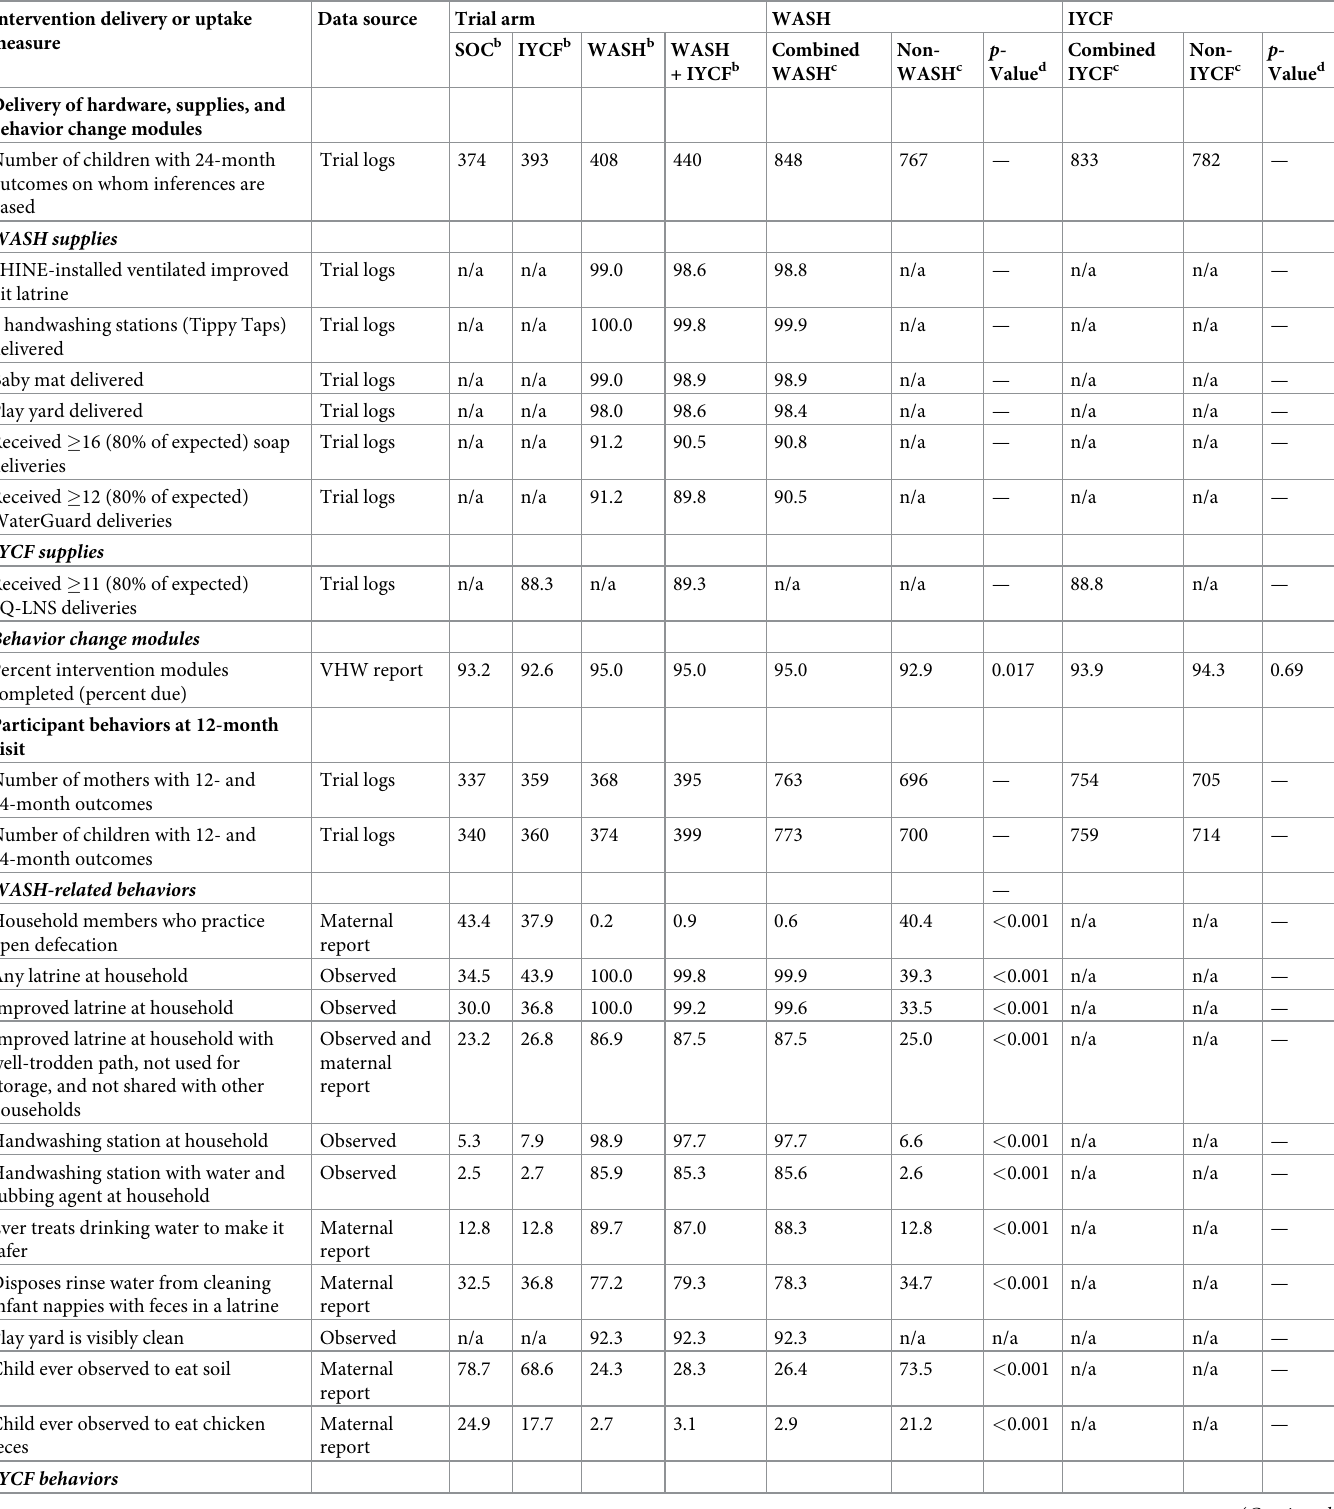
Table 3. Intervention delivery and participant uptake by treatment group a . Intervention delivery or uptake